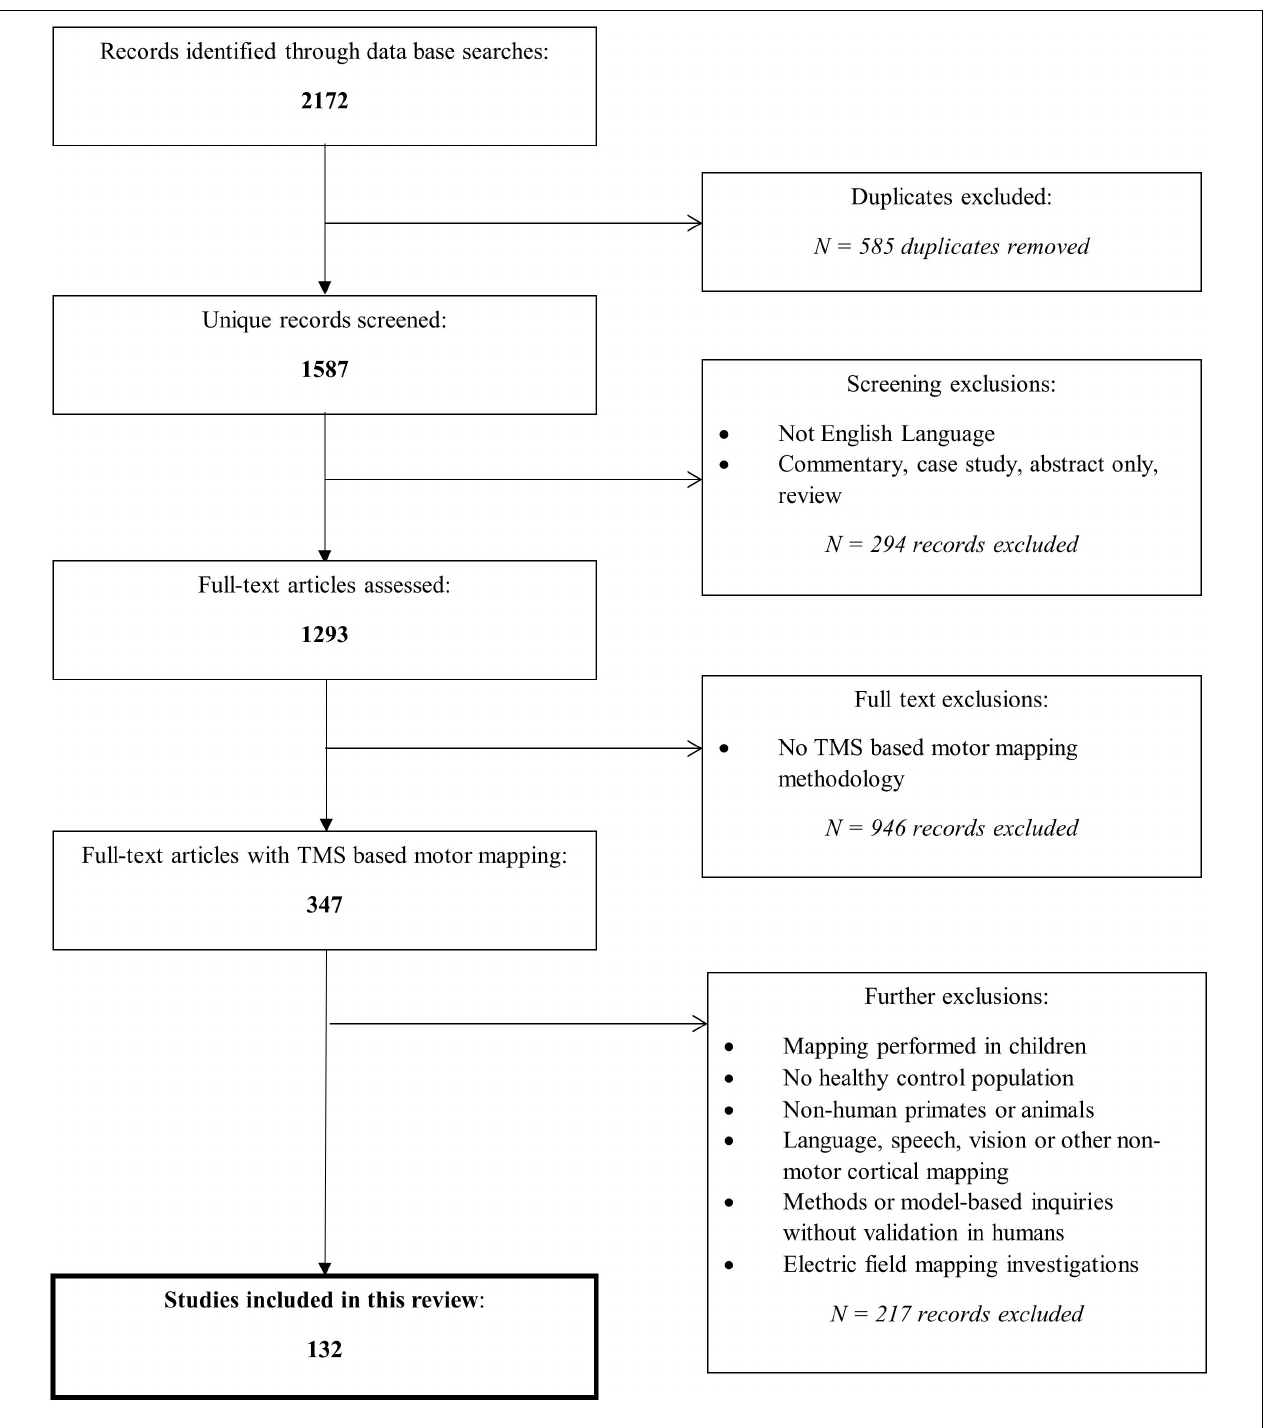
FIGURE 1 | Overview of search process. The search strategy differed slightly between the databases due to their search convention, however, can be generally summarized by: (brain OR cortex OR cerebral) AND (map OR localization OR localization OR organization OR representation OR reorganization) AND (reprodu* OR repeat* OR valid* OR stab* OR verif* OR *re-test OR reliab* OR variab*) AND (transcranial magnetic stimulation). Reasons for exclusions of record screening included: case studies, poster abstracts, reviews, and commentaries or entries that were not written in English. Reasons for excluding full-text articles were: not studying TMS based motor mapping such as mapping of the visual system, evaluating motor response strength (MEPs) but not geographical map representation, or modeling studies without human experimental validation, mapping studies with different primary outcome measures (for example, latency) than those of interest in this review were also excluded. Additional exclusions are stated. Each database was queried using the criteria outlined on October 1st, 2020; the search included entries indexed on the databases at that time.